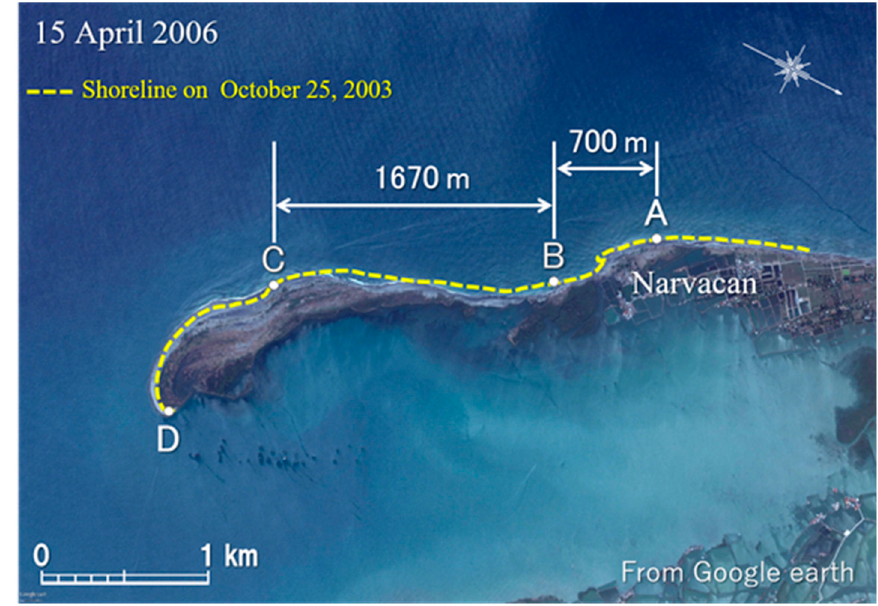
Figure 22. Satellite image around the sand spit at Santo Tomas (15 April 2006).